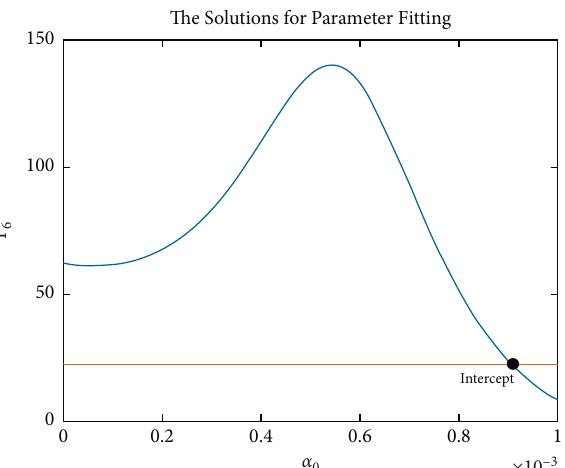
for a particular time window. The 0 ( α ) , equation (23) when α 6 0